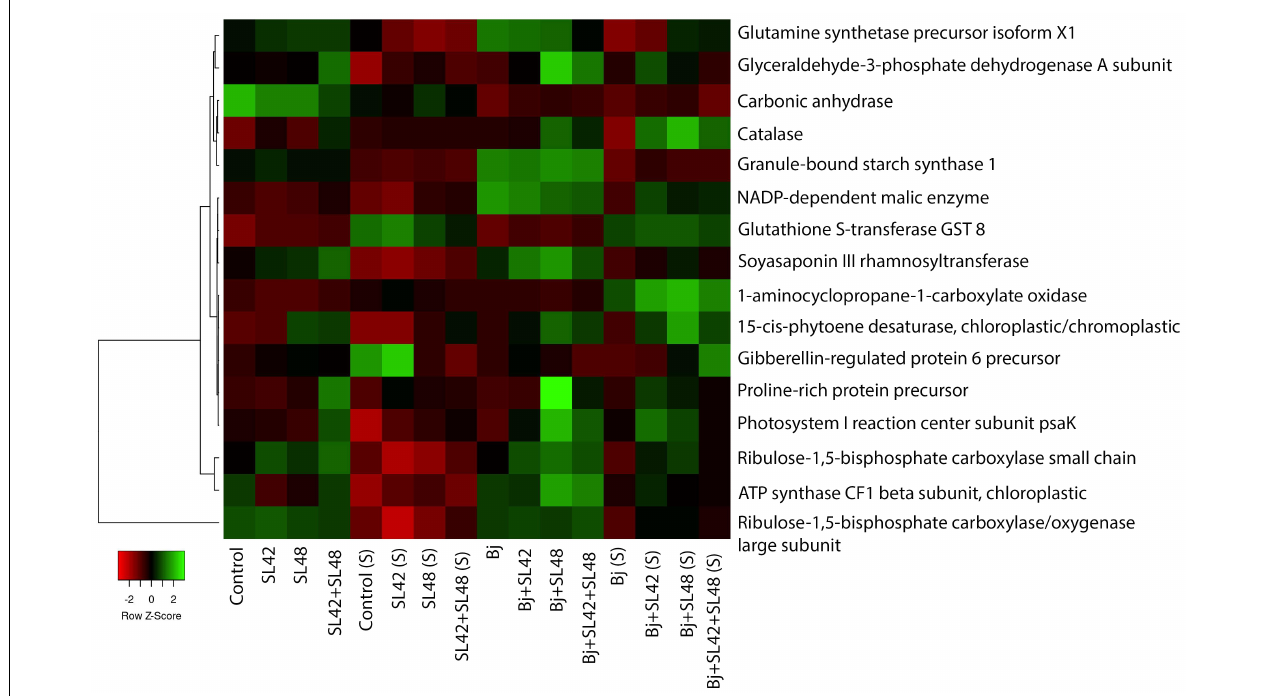
FIGURE 4 | Heat map generated based on quantitative spectral data of selected proteins. Color gradient represents changes of spectral values between treatments and mapped to row scaled data on Y-axis. The small panel in the bottom left corner shows the difference from down-regulated (red) to up-regulated (green). Average linkage clustering and Euclidean distance measurement were